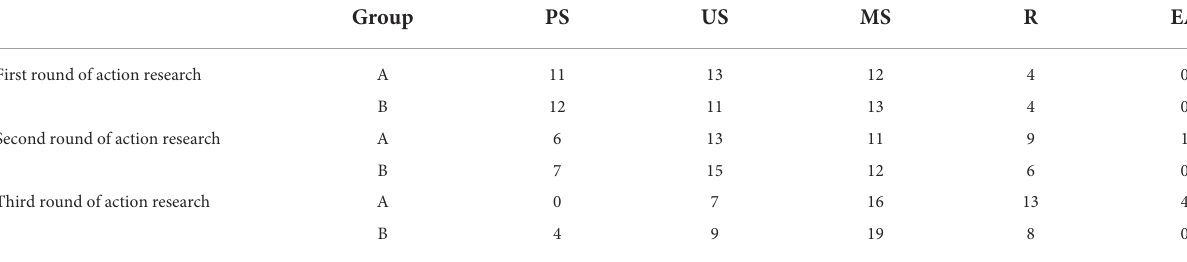
TABLE 1 The number of students’ works in each level of understanding. Group PS